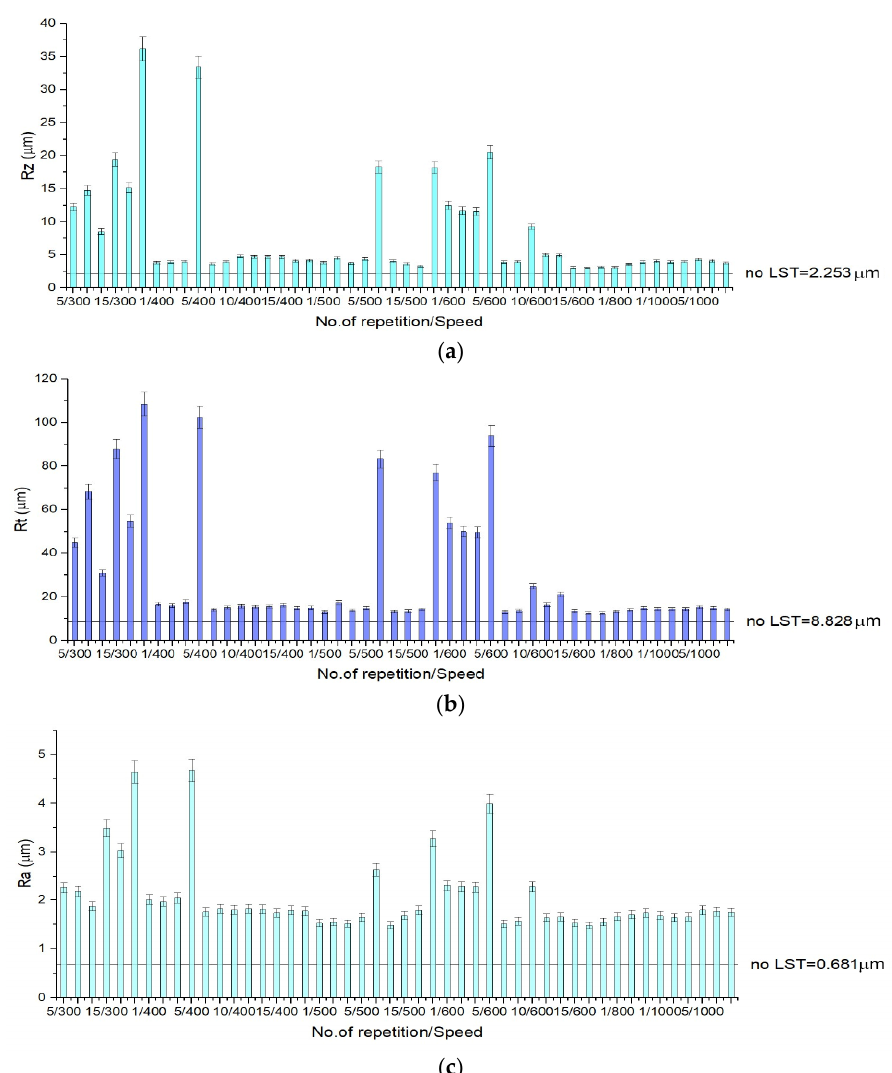
Figure 9. Surface roughness charts for design type B, R z —deviation from the mean line, specifically focusing on the highest peak and valley ( a ), R t —total height of the roughness profile of the deepest valley within the evaluation length ( b ) and R a —measures the average length between the peaks and valleys and the deviation from the mean line on the entire surface ( c ).